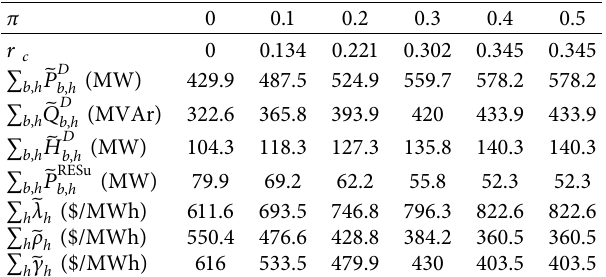
Table 5: True value of uncertainty parameters at the worst-case scenario for diferent values of robustness